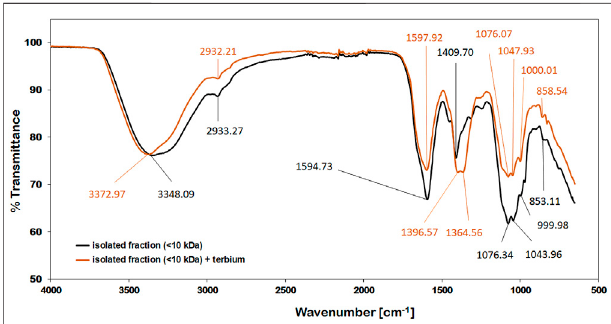
FIGURE 8 | IR-spectra of the isolated ( < 10 kDa) compounds; before (black) and after adding 1 µmol of Tb 3+